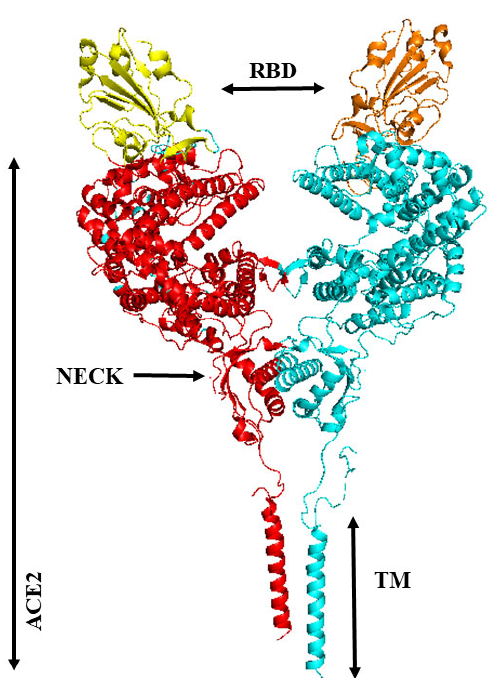
Figure 7. The three dimensional structure of an ACE2 homodimer molecule bound with two RBDs (yellow and orange) (PDB ID: 6M17, [247], PyMol molecular graphics system). ACE2 monomers are in red and greenish ‐ blue colors. The “Neck” region is involved in homodierization of monomeric form of ACE2 molecules. PD: ACE2 peptidase domain, RBD: receptor biding domain of SARS ‐ CoV ‐ 2 S protein, TMD: ACE2 trans ‐ membrane domain.